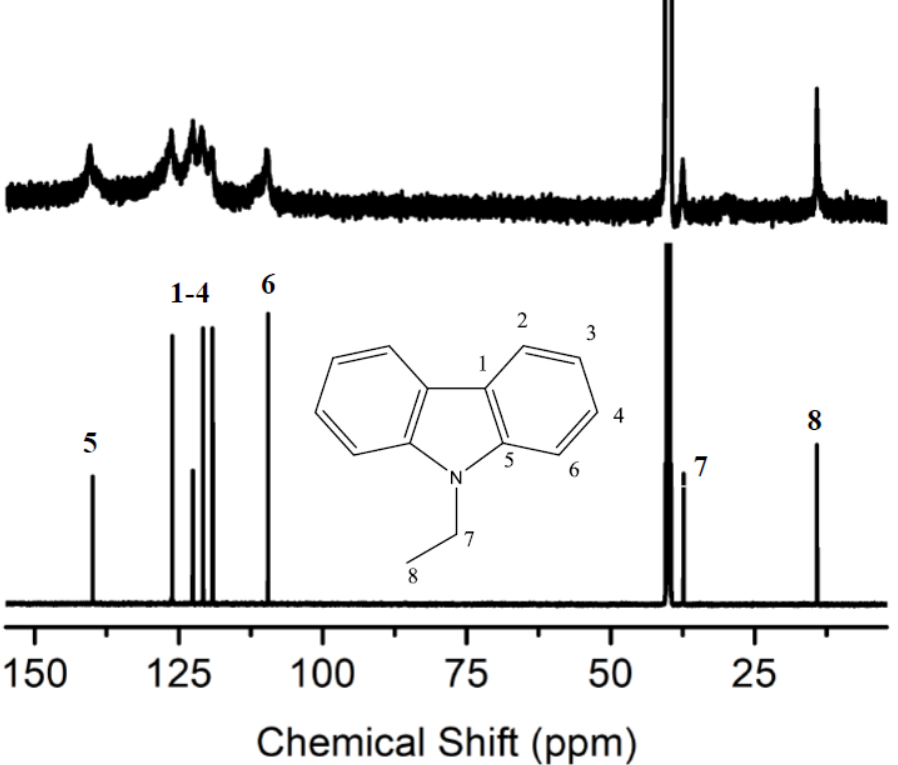
Figure 7. 13 C NMR spectra NEC-CDots (upper) and free NEC (lower), both in DMSO- d 6